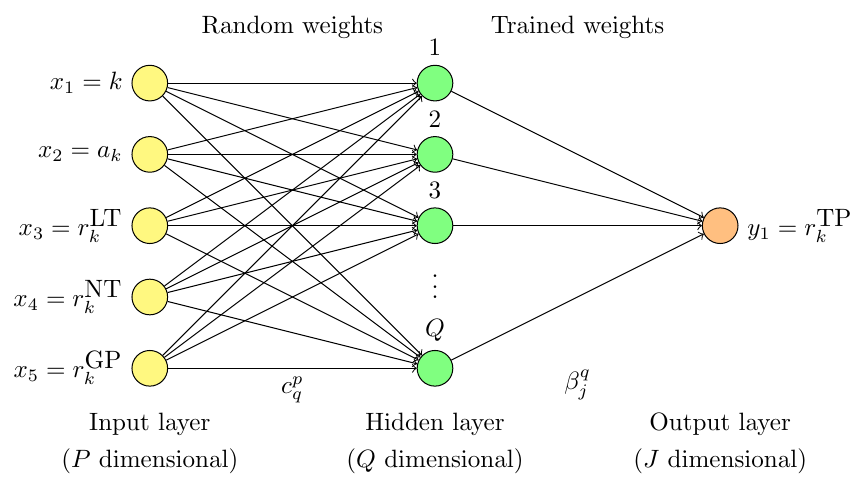
Figure 1. Schematic representation of the extreme learning machine (ELM) neural network architecture utilized for the data-driven reduced-order modeling framework in this study.